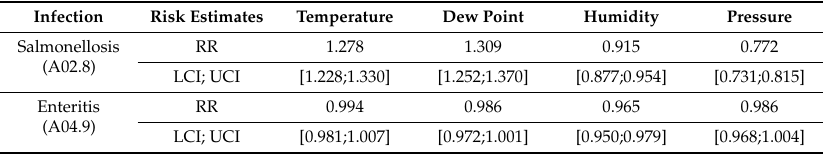
Table 7. Results of log-linear regression model for health outcomes: estimates of relative risk associated with weather parameters. Infection Risk